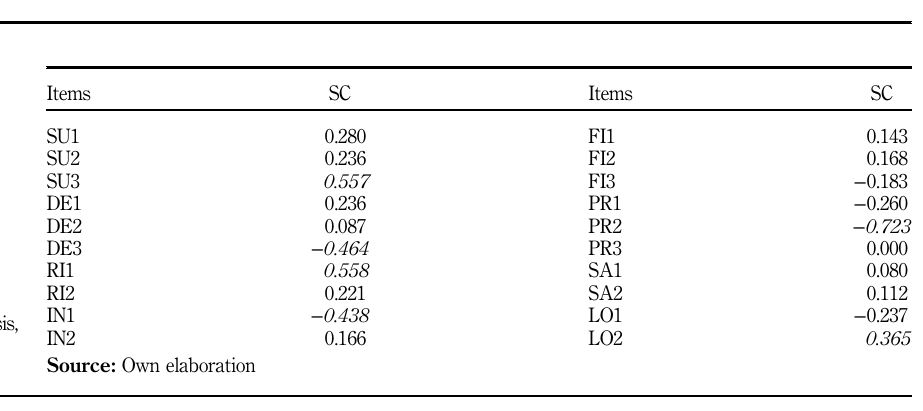
Table X. Discriminant analysis, basic data